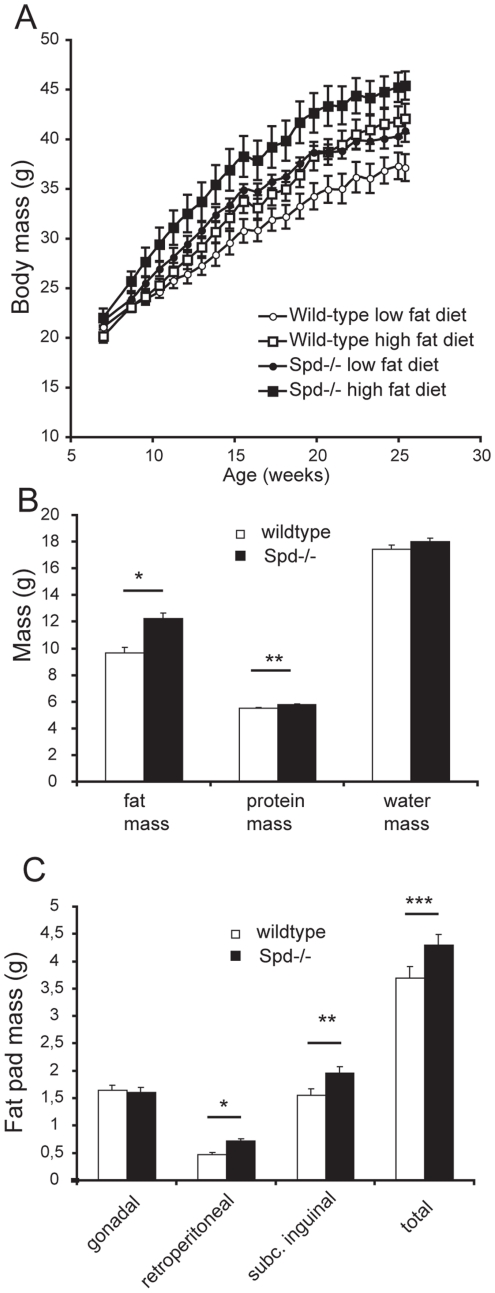
Mean body masses of male mice fed ad libitum for 18 weeks.A) Spd−/− mice had a higher body mass than their wild-type counterparts. ANOVA of AUC showed a genotype effect (p = 0.005) and a diet effect (p = 0.02). Diet did not influence the body mass difference of genotypes. Data are means ± SE, n = 6. B) Carcass mass of protein, fat and water in 28 week old mice. Protein and fat mass was increased in Spd−/− mice. Genotype effect, * p<0.001 and ** p = 0.038. Data are least square means ± SE, n = 11–12. C) Mean masses of three fat pads in 28 week old mice. The gonadal fat pad mass was similar in the two genotypes. Retroperitoneal fat, subcutaneous fat and the total of the three pads were increased in Spd−/− mice. Genotype effect, * p = 0.001, ** p = 0.03, *** p = 0.047. Data are least square means +/− SE, n = 11–12.